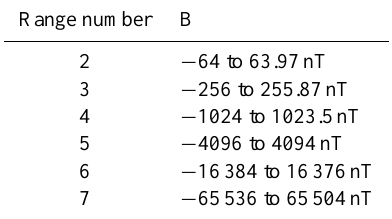
Table 1. FGM instrument ranges.